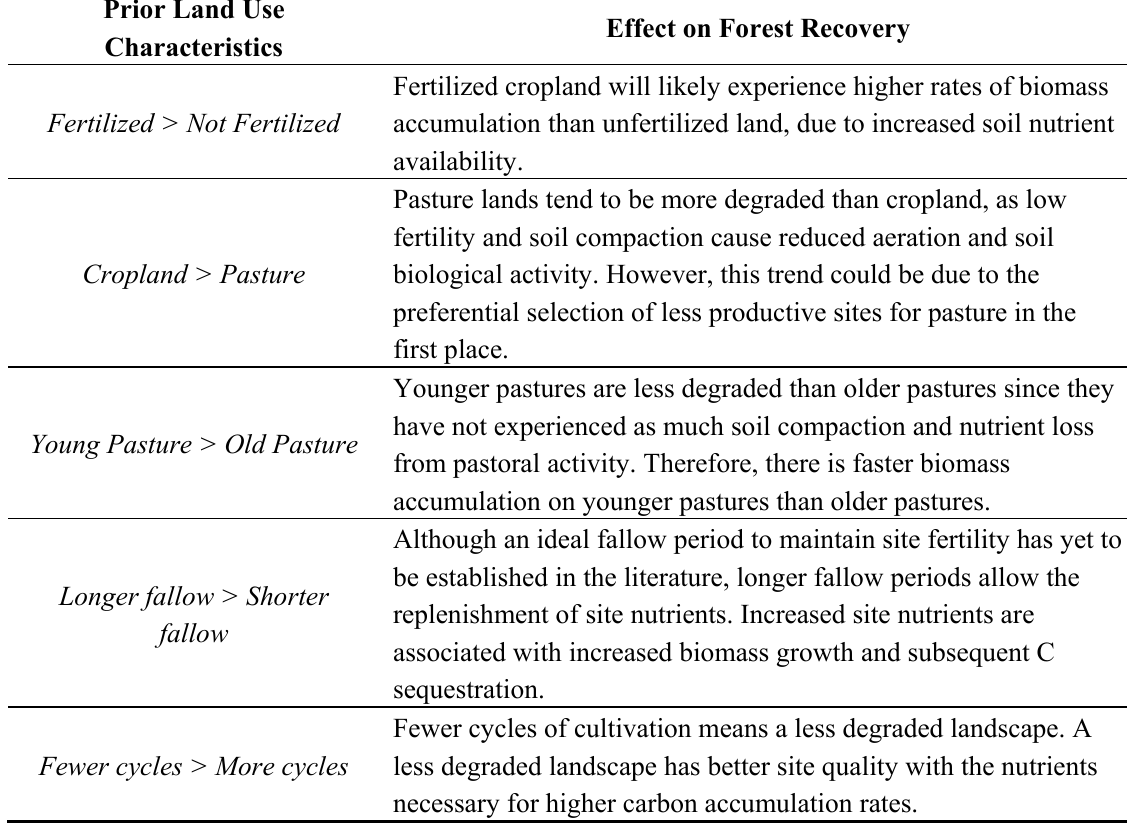
Table 1. Prior land use practices and their associated effect on forest recovery. These are trends generally agreed upon in the literature concerning C sequestration on abandoned land given certain site history